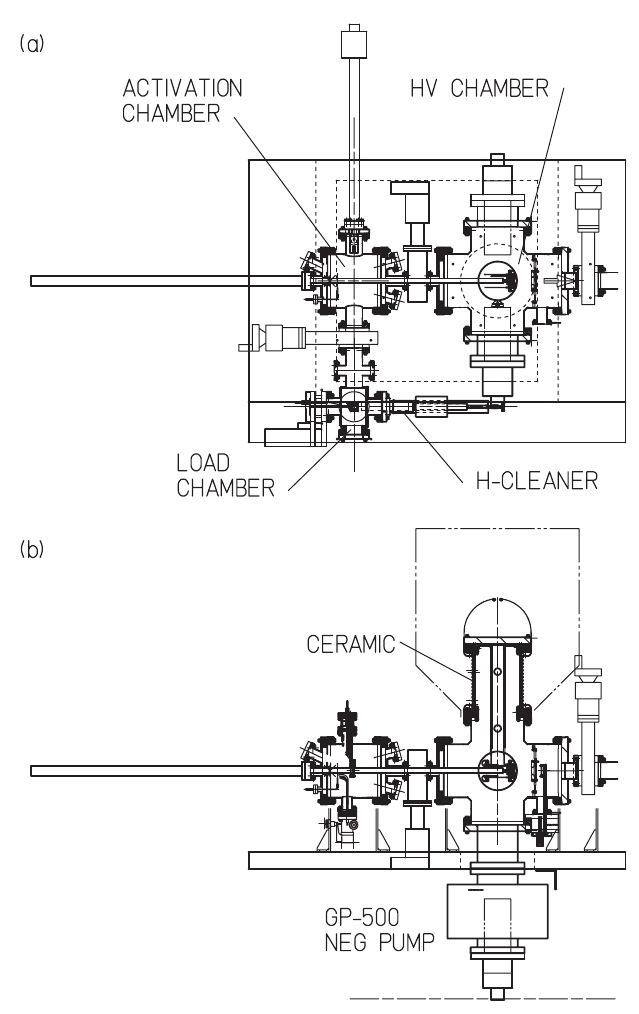
FIG. 14. The CEBAF load-locked gun: (a) top view; (b) side